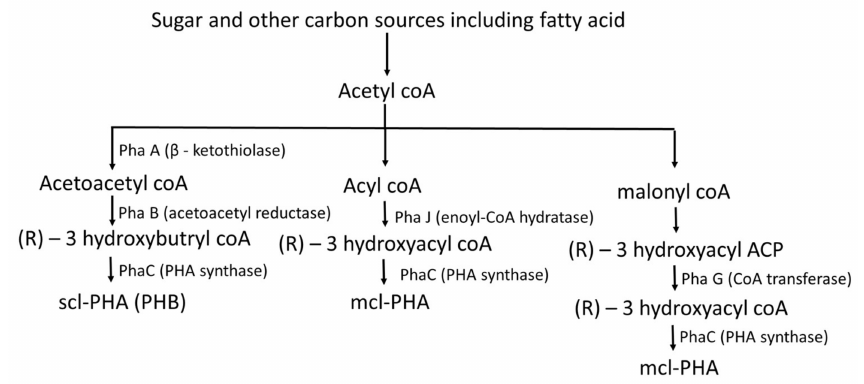
Figure 2. Biosynthesis of Polyhydroxyalkanoate